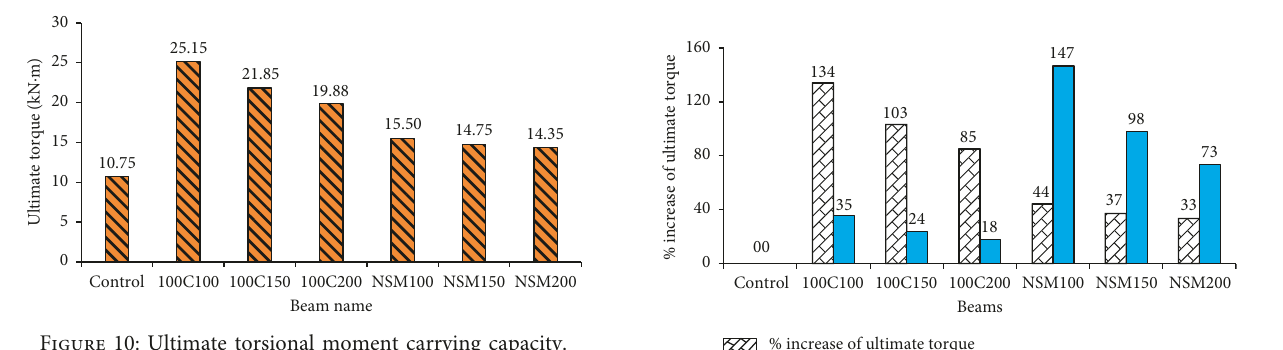
Figure 10: Ultimate torsional moment carrying capacity.